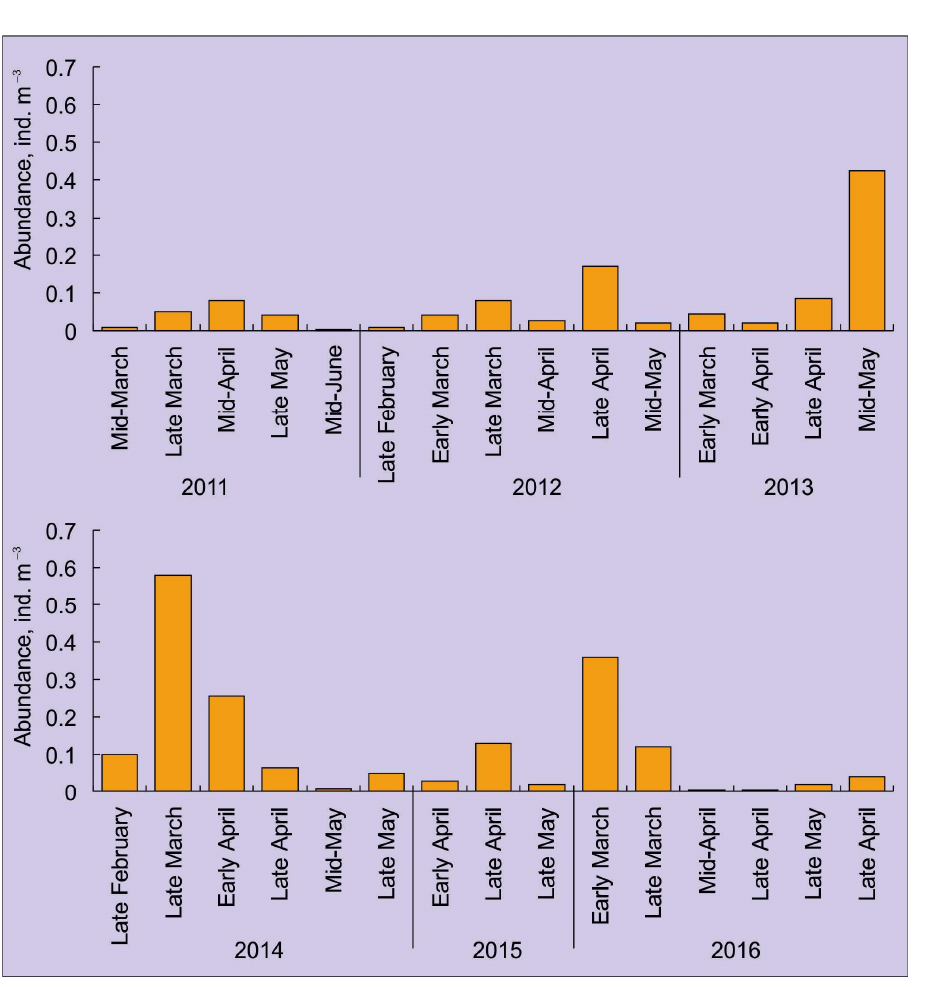
Figure 6. Seasonal abundance (individuals m –3 ) of red king crab larvae in Russian waters of the Barents Sea (2011–2016, Ura Bay) (modified from [81,84]).